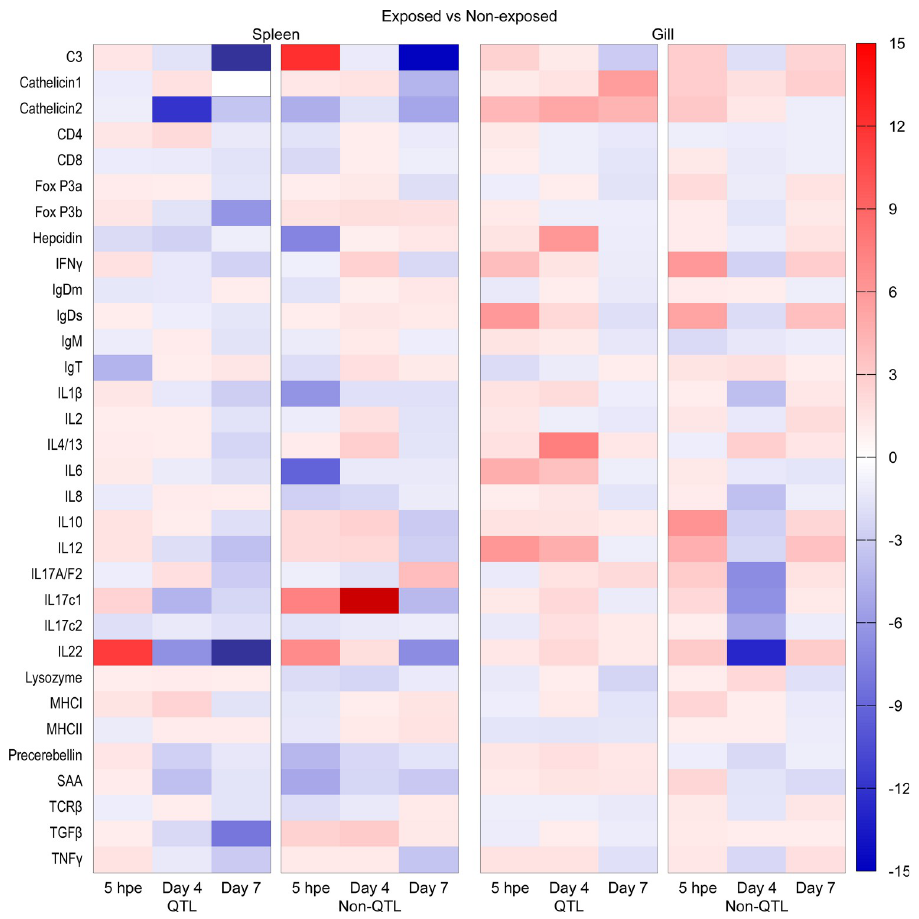
Fig 4. Overview of gene expression in gill and spleen of QTL and non-QTL fish on 5h, 4 and 7 days post exposure.